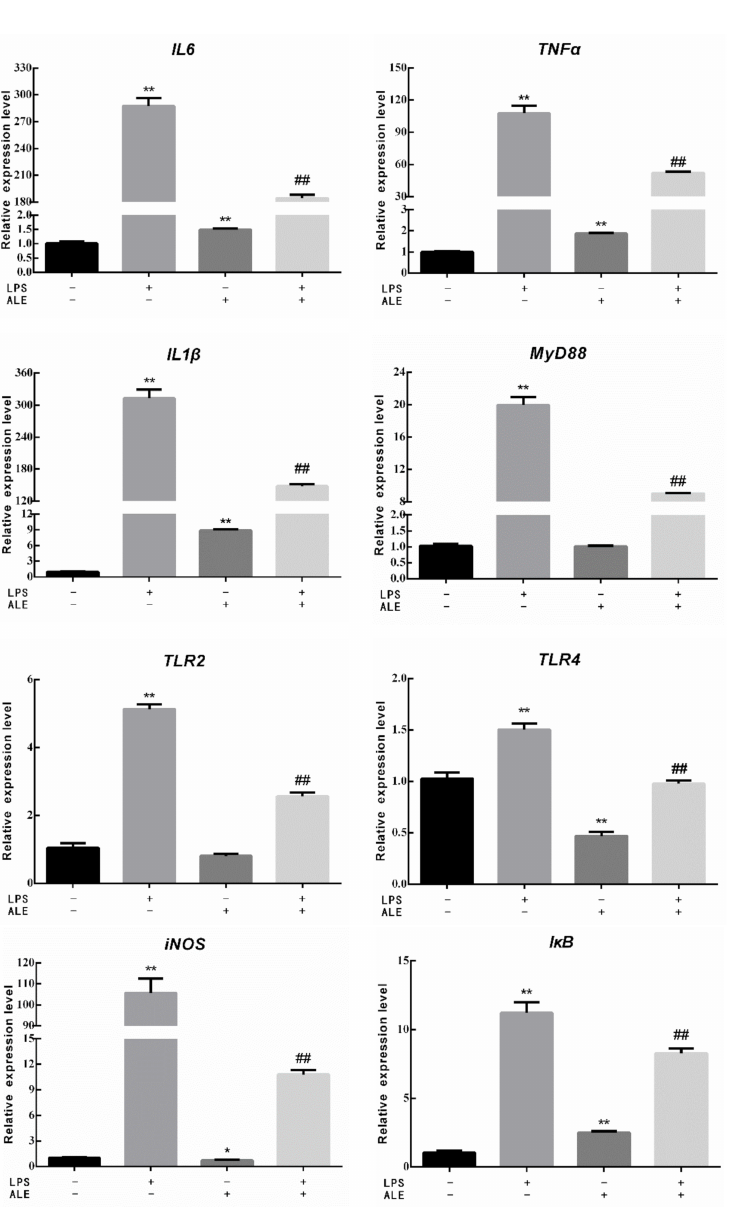
Figure 5. Effects of ALE on LPS-induced mammary tissue related genes in mice. * p < 0.05, ** p < 0.01 vs. control group; ## p < 0.01 vs. LPS